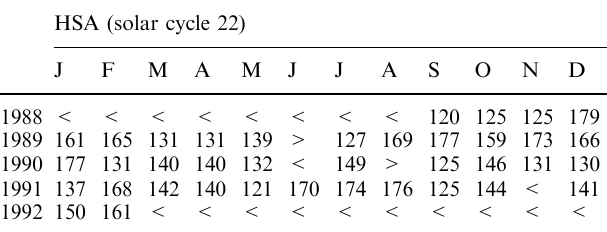
Table 2. Monthly mean sunspot numbers R for the cycle-22 solar maximum period 1988–1992 [ < : R < 120 (not selected), > : R > 180